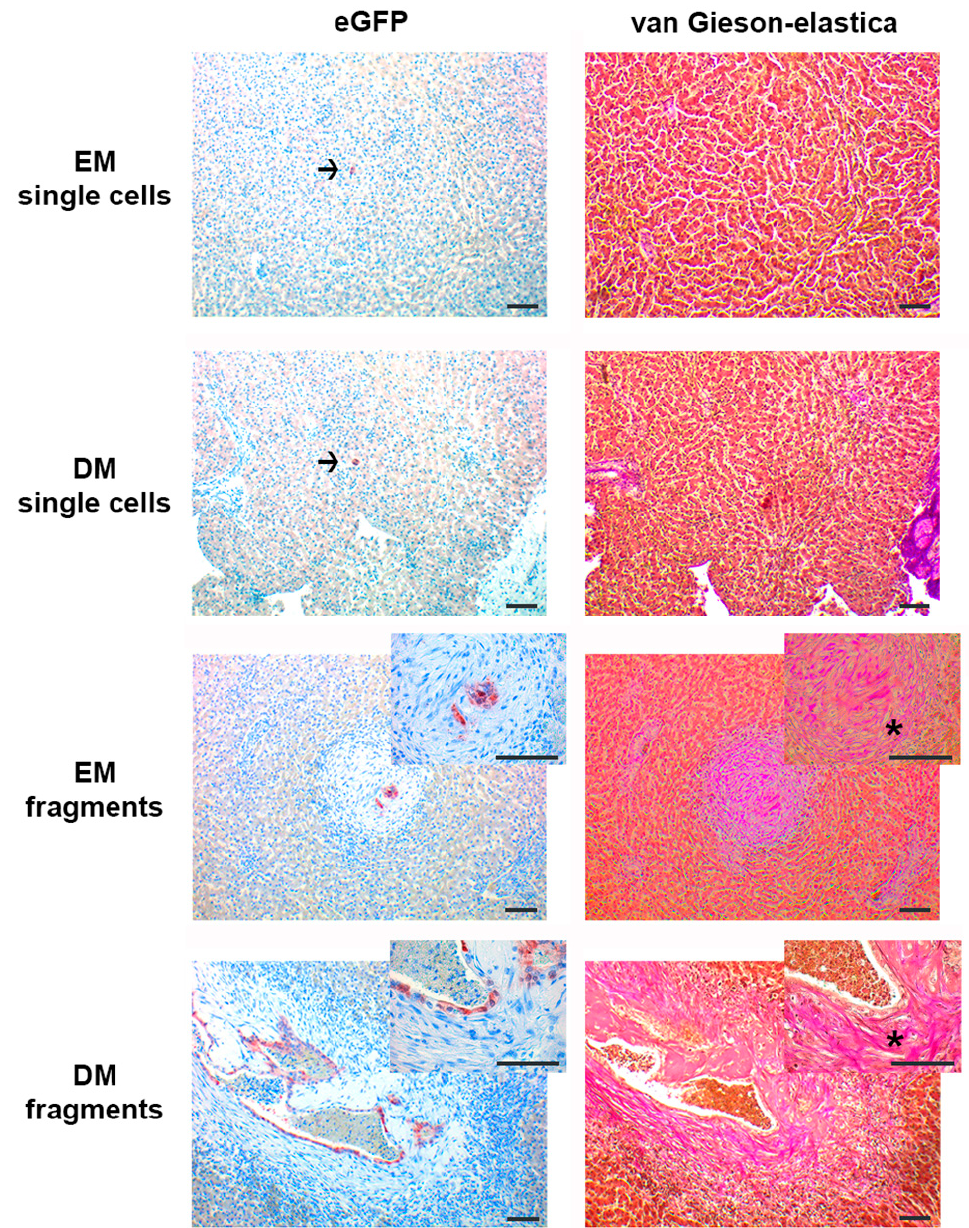
Figure 2. Organoid engraftment after intrahepatic injection. Representative images of serial immunohistochemistry stainings for eGFP (red chromogen) and Elastica van Gieson staining of liver one week after injection with undifferentiated (EM) and differentiated (DM) organoid-derived single cells vs. organoid fragments. All conditions showed engraftment (arrows highlight engrafted single cells). Extracellular matrix deposition (*) can be seen surrounding EM and DM organoid fragments, but not around single cells. Scale bars represent 50 µm.